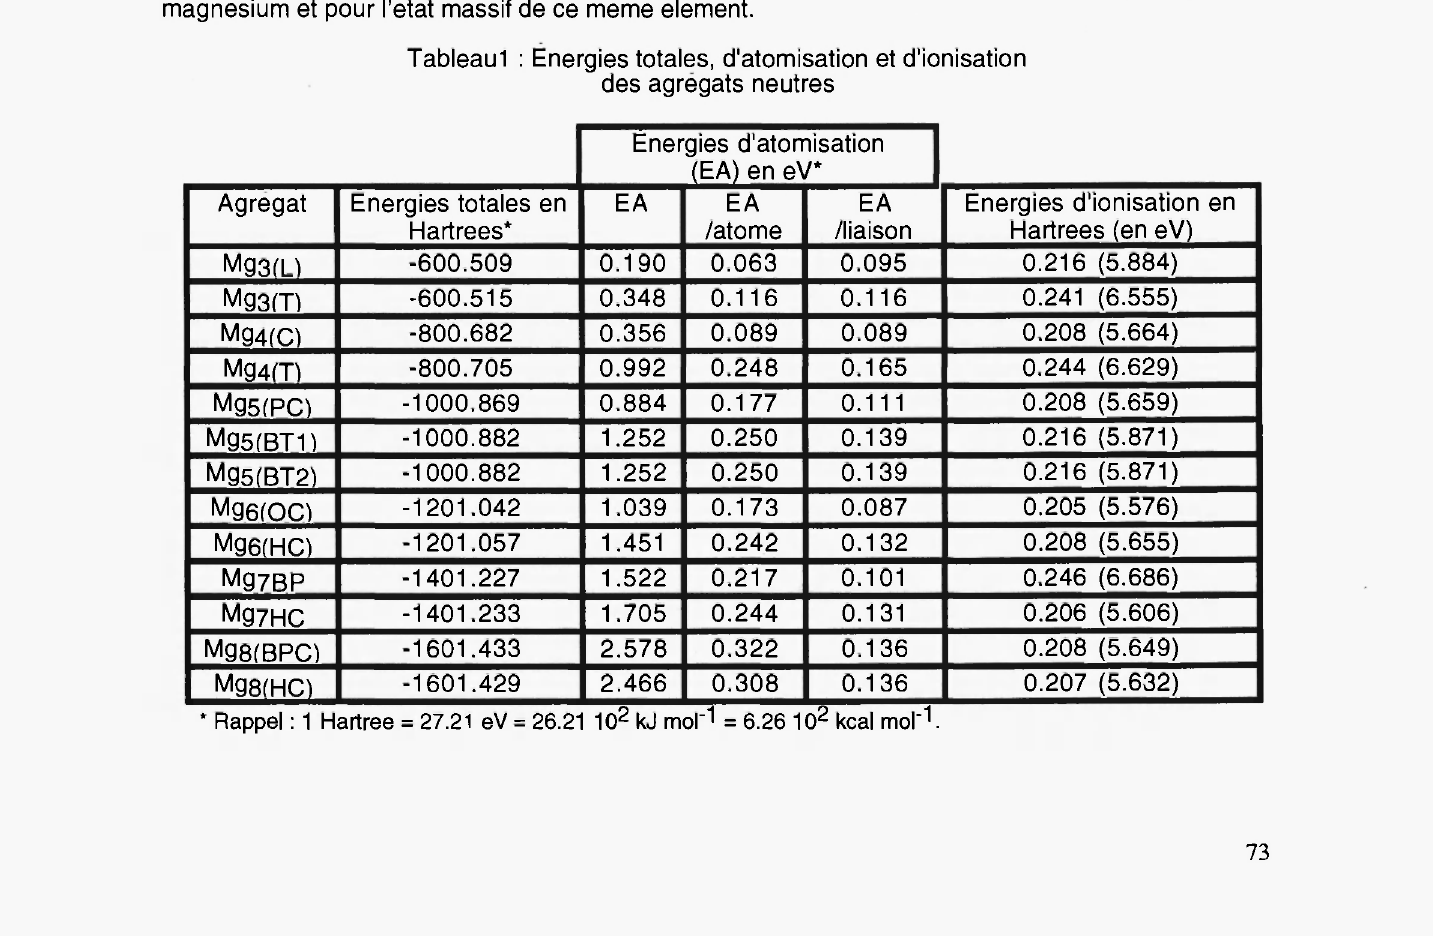
Tableaul : Energies totales, d'atomisation et